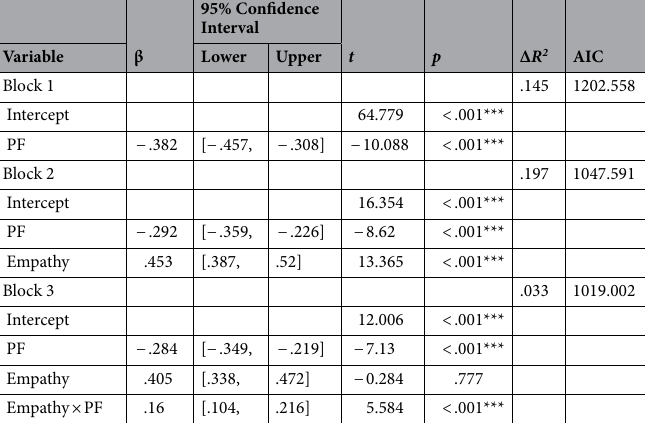
Table 2. Hierarchical linear regression of support for public health measures predicted by pandemic fatigue, empathy, and empathy × pandemic fatigue interaction. PF pandemic fatigue, AIC akaike information criterion. * p < .05, ** p < .01, *** p < .001.